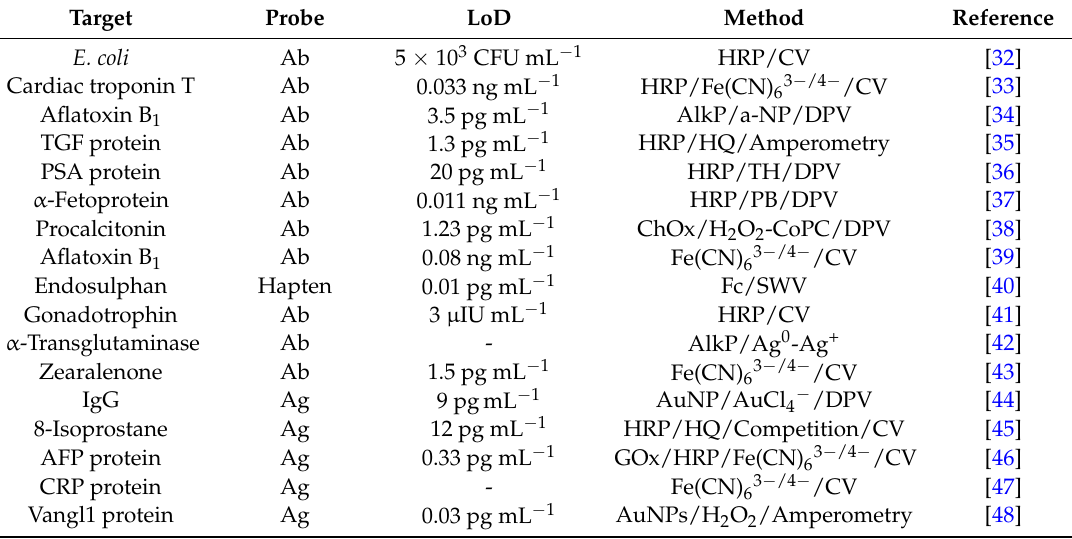
Table 3. Figures of merit of selected immunosensors using carbon